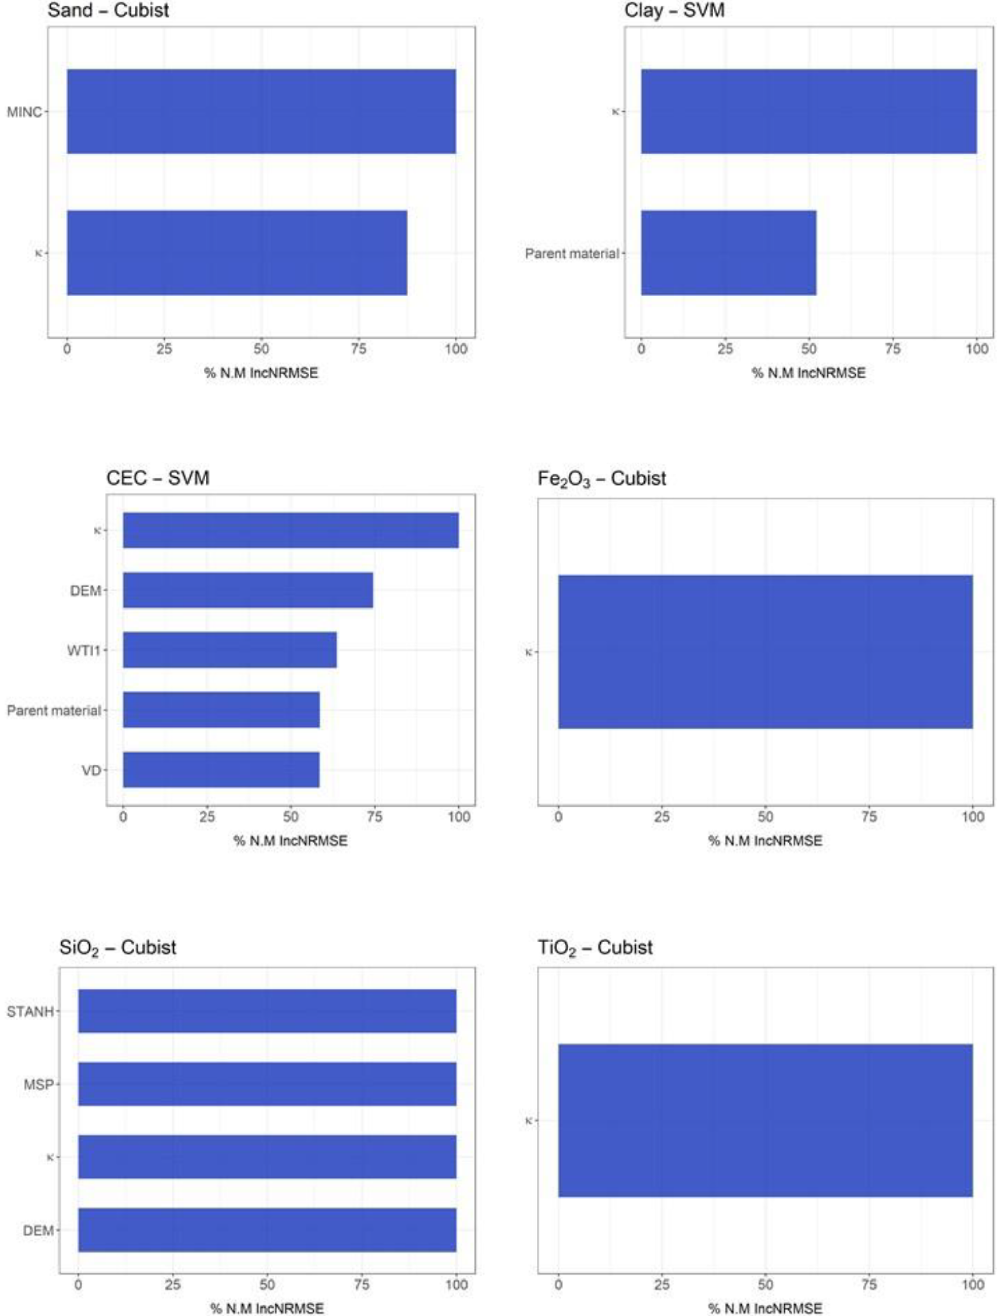
Figure 5. Variable importance for susceptibilimeter + conductivimeter sensors (only variables that contributed more than 50% are presented here; for further details see